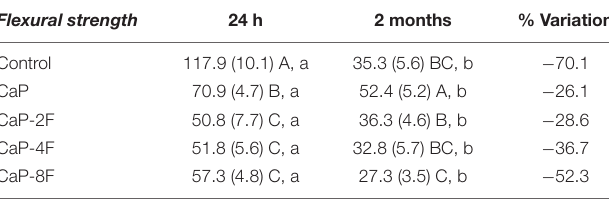
TABLE 2 | Means (standard deviations) of maximum flexural strength (MPa).